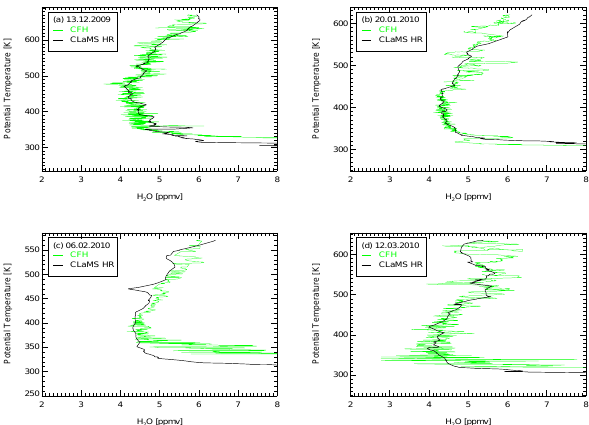
Fig. 3. Comparison of CLaMS H 2 O mixing ratios (black) with bal- loon borne CFH observations (green) made from Sodankylä for dif- ferent times throughout the winter. Shown are ascent profiles from